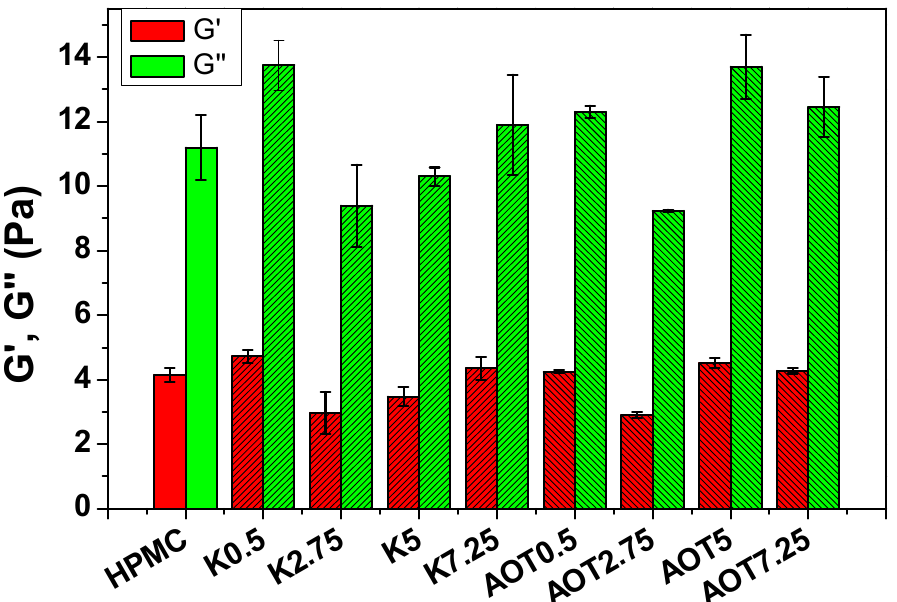
Figure 2. G ′ and G ″ obtained for precursor hydrogels by SAOS tests at a frequency of 0.1 Hz and a strain amplitude of 0.5%.